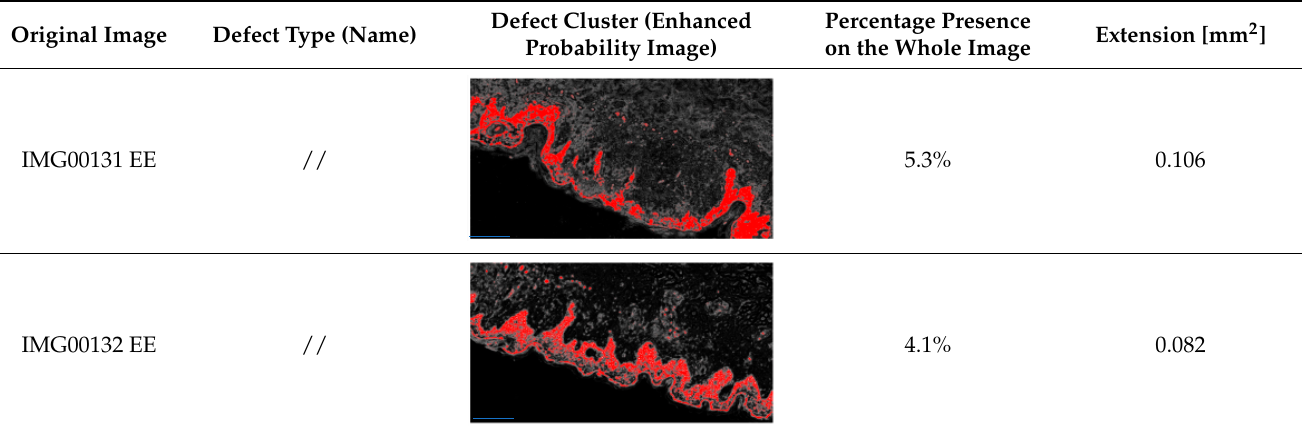
Table 2. Example of analysis of two micrographs of malignant melanoma in which some constituent elements of the Allen–Spitz criteria have been analyzed, such as: symmetrical or asymmetrical lesion, clustering of melanocytes in nests or presence of single melanocyte, and eventual pagetoid spreading.